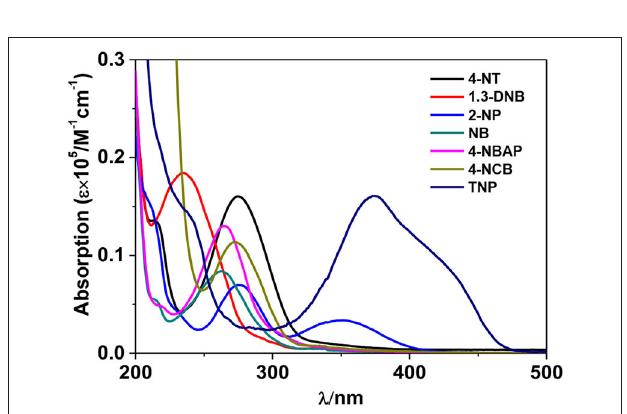
FIGURE 11 | UV-vis absorption spectra of explosives in CH 3 CN.